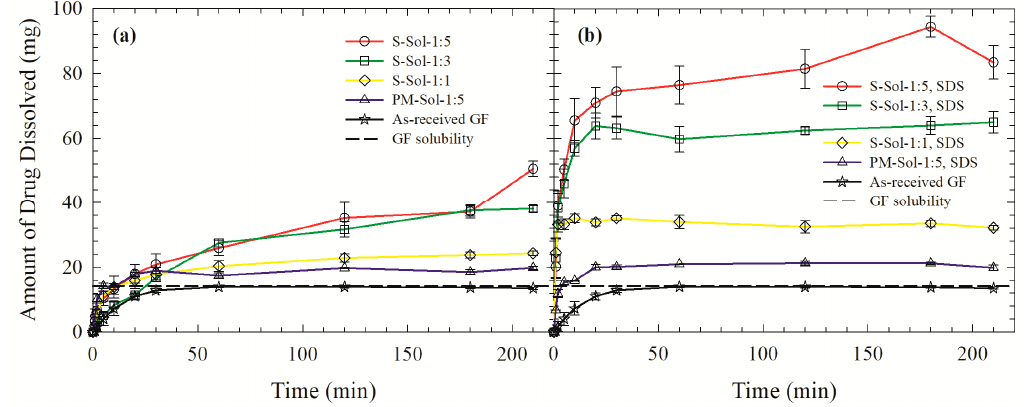
Figure 6. Evolution of drug release from as-received GF, physical mixture (PM) with 1:5 GF:Sol mass ratio, and spray-dried powders prepared using the GF solutions with 1:1, 1:3, and 1:5 GF:Sol mass ratios: ( a ) Sol without SDS, ( b ) Sol with SDS.